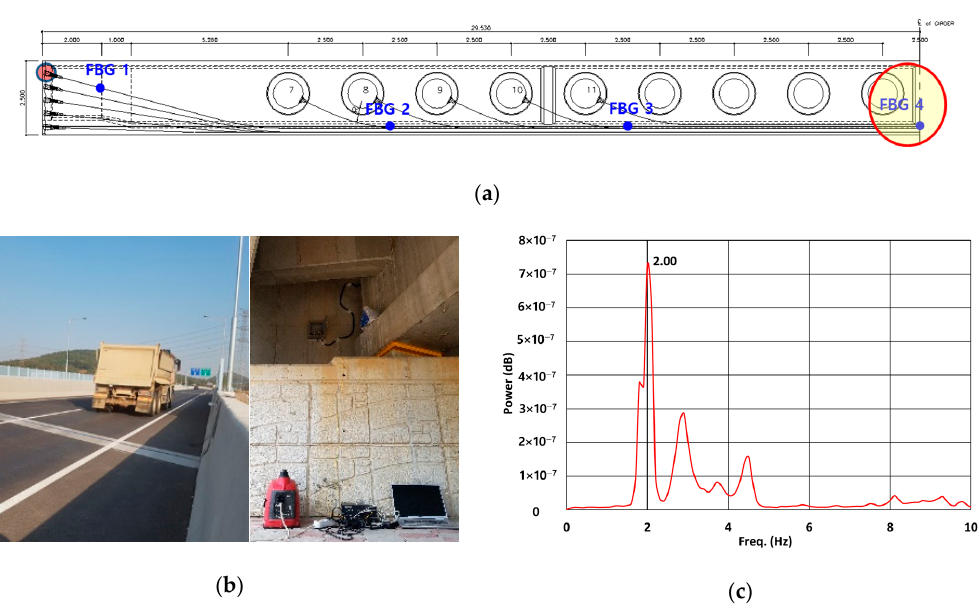
Figure 14. Real bridge applying the OSPC strand: ( a ) Overview of bridge and layout of sensors; ( b ) Photograph of the completed bridge and dynamic data acquisition equipment; ( c ) Natural frequencies extracted from acceleration data.